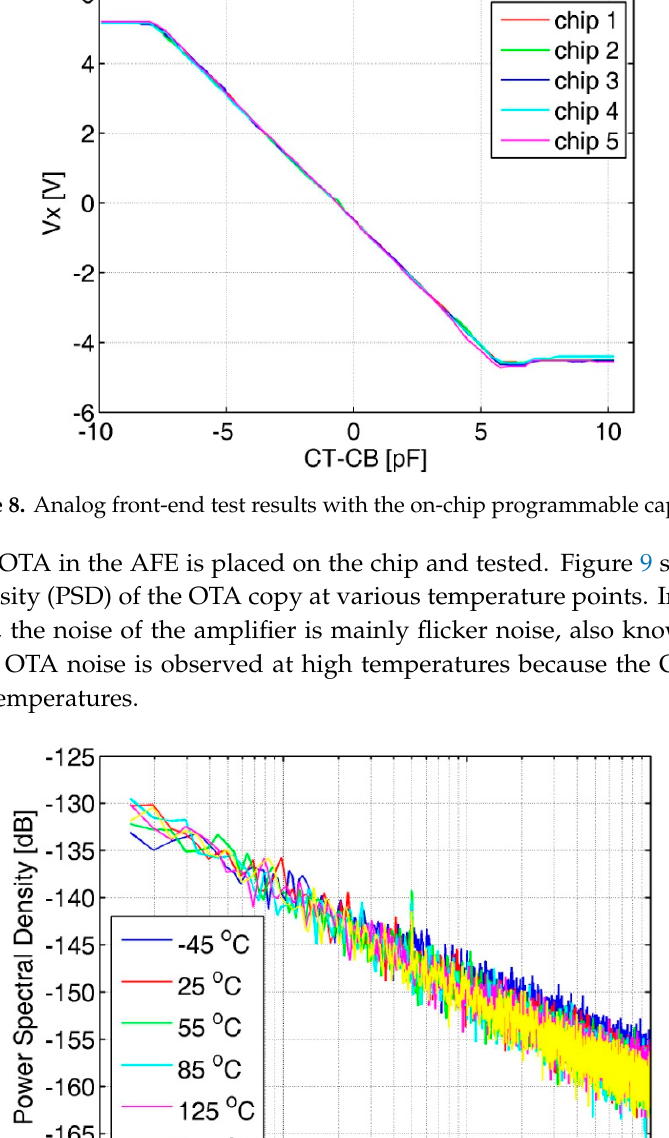
Figure 10. Noise PSD of the bandgap voltage reference at 175 °C. A summary of the measurement noise results for the proposed bandgap along with a comparison of performance between the other five references is shown in Table 1. It can be seen that this work exhibits good noise performance at a wide temperature range. Table 1. Performance of Bandgaps. Parameter